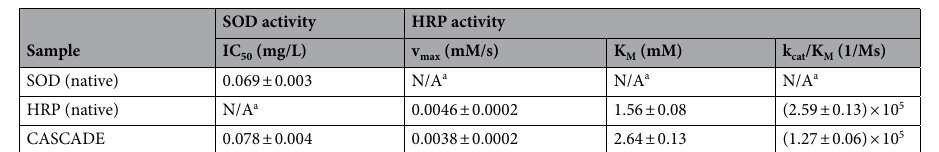
Table 1. Enzymatic activity and kinetic parameters of CASCADE and the native enzymes. The average error of the assay measurements is about 5%. a The enzyme was inactive, i.e., the enzymatic activity could not be